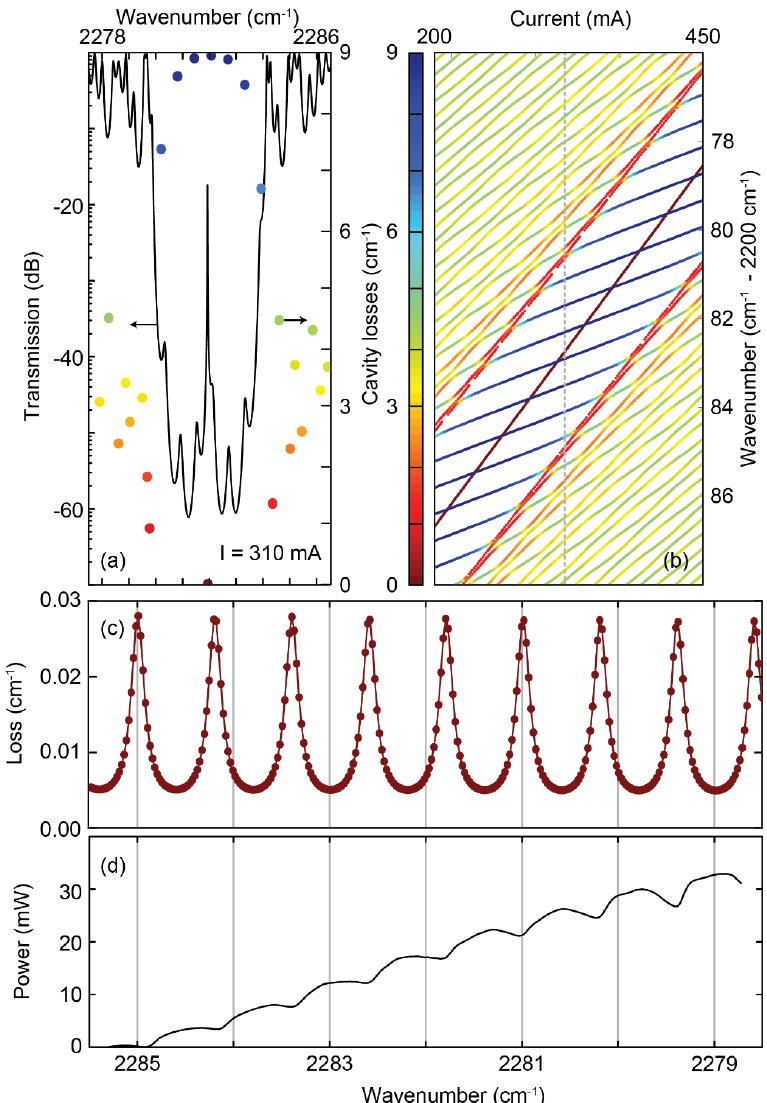
Figure 4. Temperature dependent TMM calculations including waveguide losses of the wave propagation in dual-section DFBs. ( a ) The transmission and the extrapolated waveguide losses of the same structure at fixed current I = 310 mA (indicated in (b) with a grey dashed line); ( b ) The extrapolated waveguide losses of all cavity modes as a function of current and frequency; ( c ) Losses of the QWS mode extracted from (b); ( d ) Mode power versus spectral position, as comparison to (c). The same effect can also be observed when operating the laser in iCW mode, which is the preferred driving approach for a dual-section DFB-QCL. Here, time-dependent FEM simulations can be used to calculate the laser temperature, similar to the stationary simulations described above. The resulting average temperature in a laser section during the pulse is depicted in Figure 5a (black dashed line). The resulting temperature profiles can again be used to calculate the cavity losses via the TMM. The green curve in Figure 5a is the result of this calculation, where the spectral position of the QWS mode was extracted for each time step. It is compared to the red curve, which shows the position of the lasing mode, determined experimentally via a boxcar measurement ( cf. Section 2.1.2.) on the rear section of a 2 × 2 mm long dual section DFB QCL. In contrast to the laser discussed above,